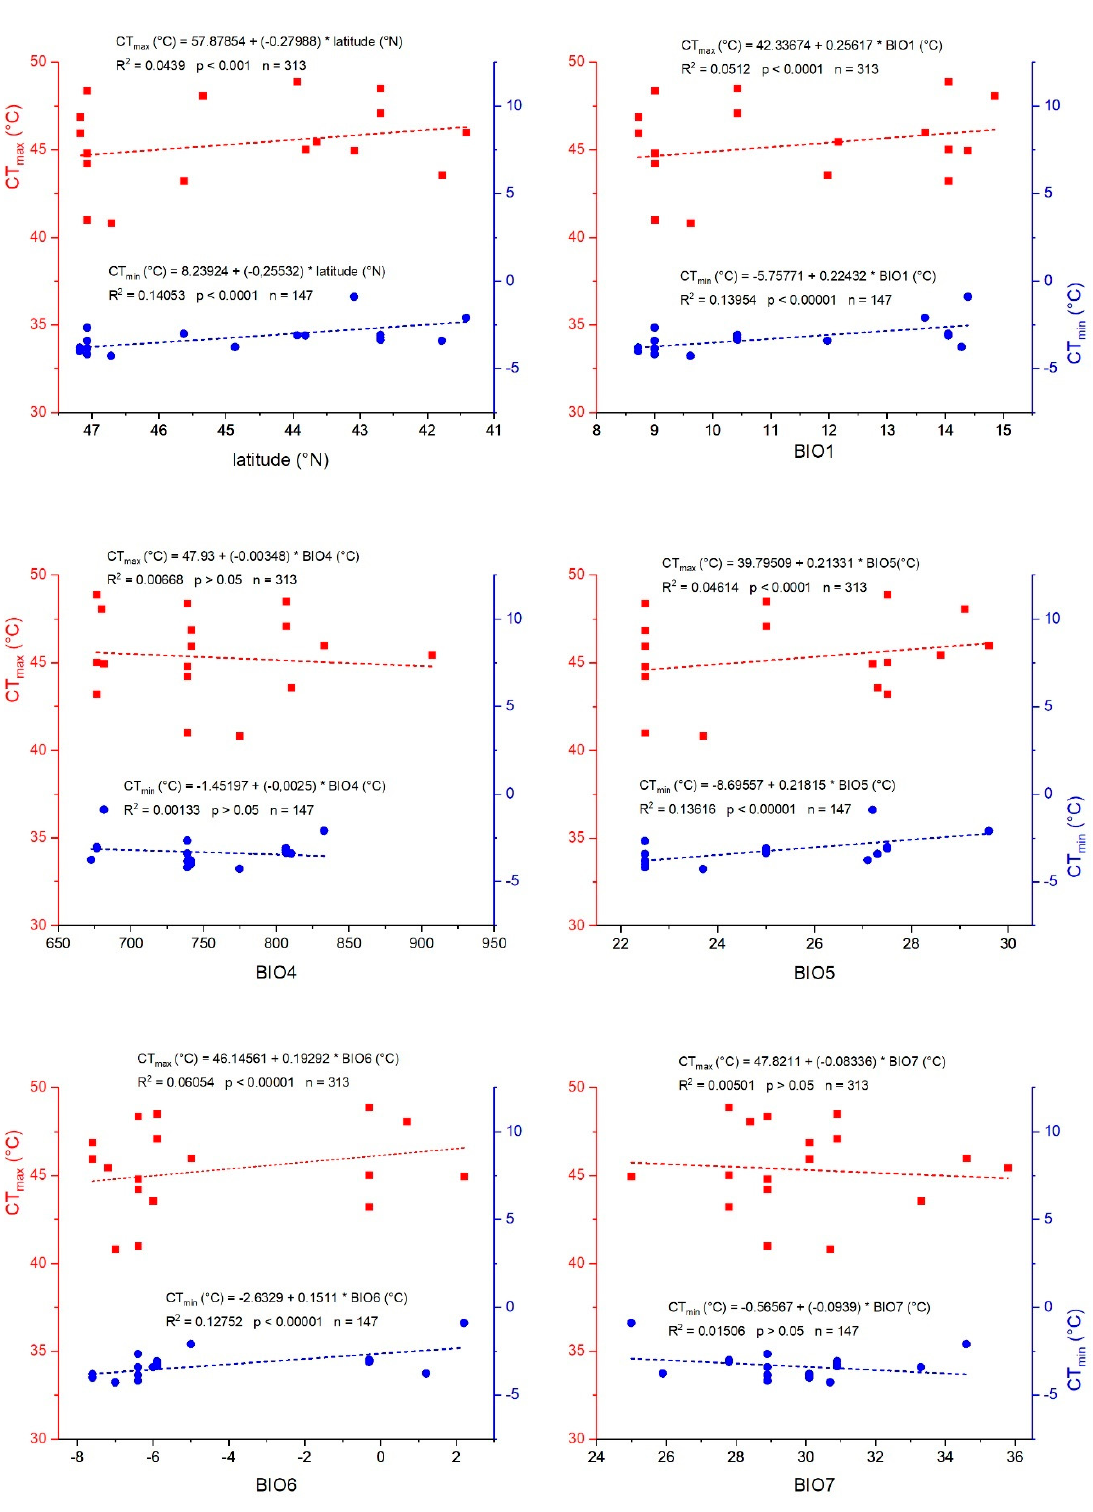
Figure 2. Correlation of physiological parameters CT min (blue) and CT max (red) with latitude and bioclimatic variables (BIO1, BIO4–BIO7; from http://worldclim.org/version2 [49]; variables are the average from 1970 to 2000). Dots represent means of individual species at certain sample sites. Correlations calculated with number of individuals. See also Table 2 and Table S2.